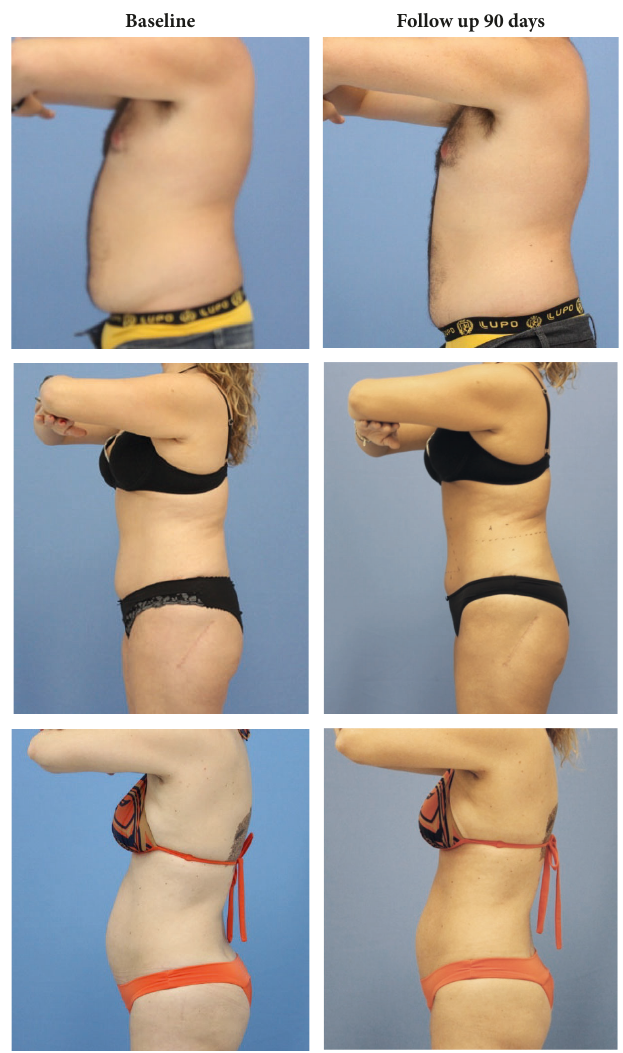
Figure 7: Comparison from the baseline and 90-day follow-up after the treatment with contrast cryolipolysis.